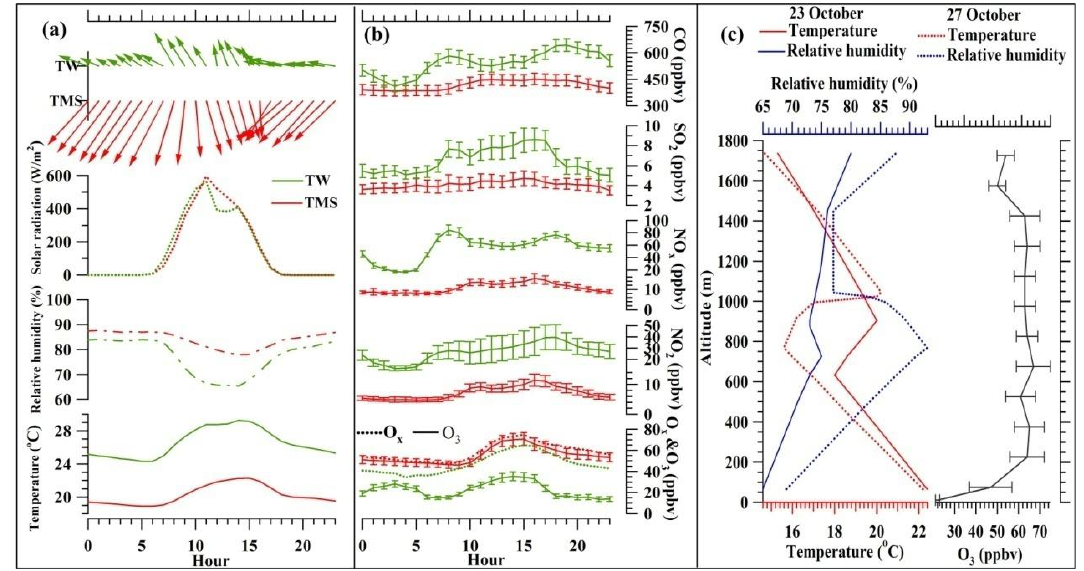
Fig. 2. (a) Surface meteorological conditions, (b) average diurnal patterns of trace gases at TMS and TW and (c) vertical profiles of meteorological conditions and O 3 in Hong